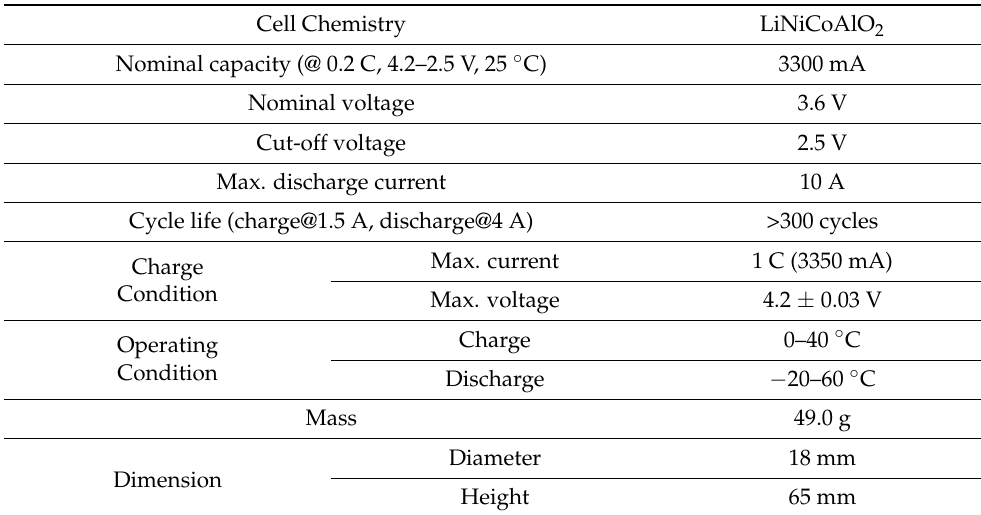
Table 4. Nominal characteristics of cylindrical Sanyo NCR 18650 GA lithium-ion cell